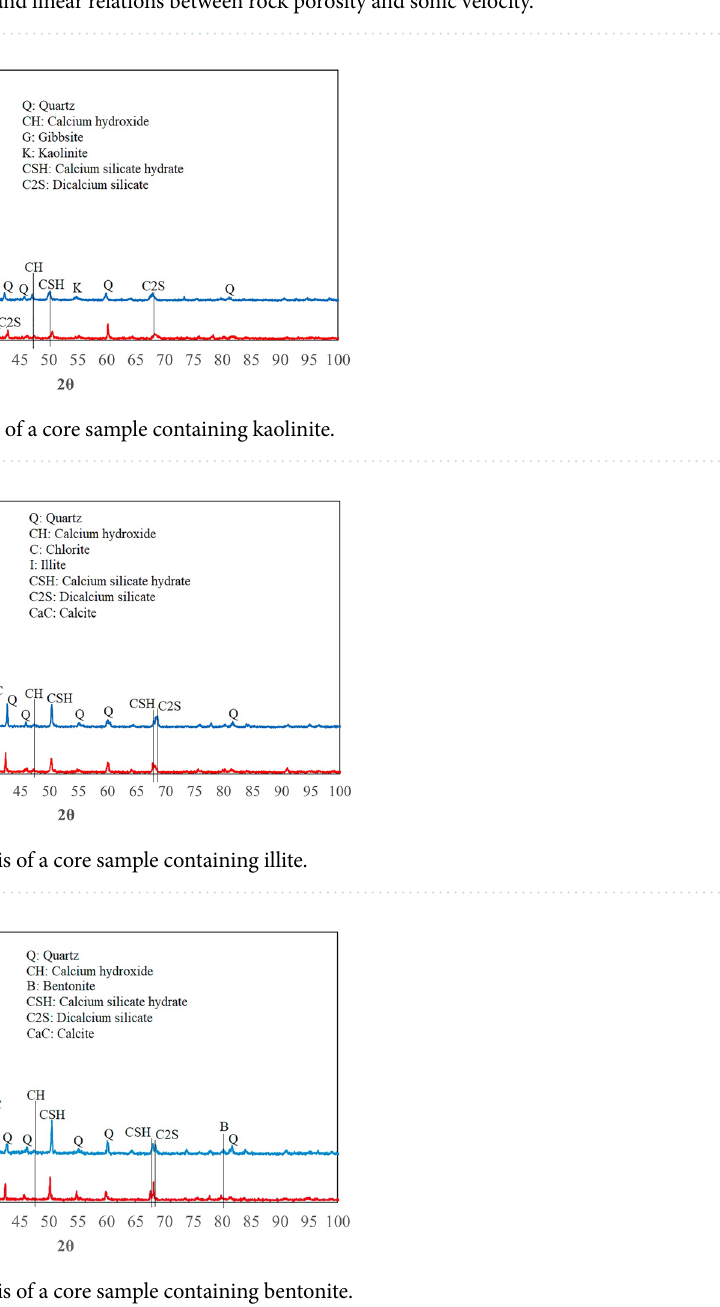
Figure 8. Exponential and linear relations between rock porosity and sonic velocity.